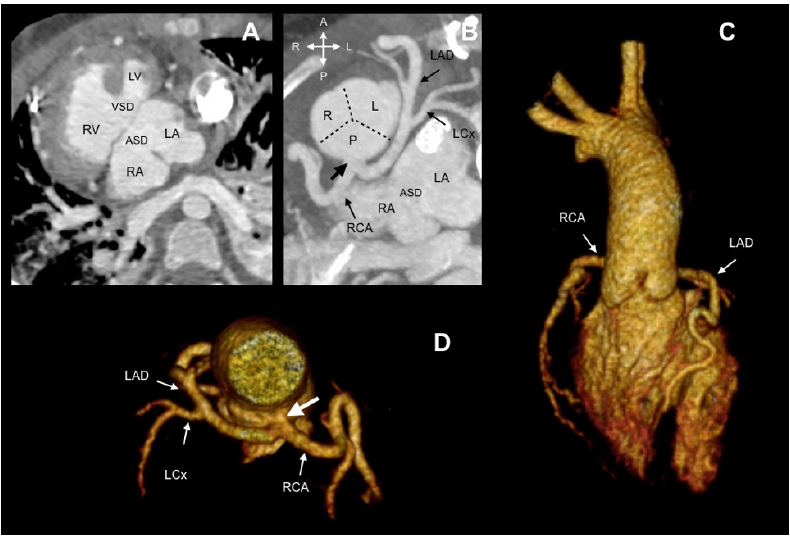
Figure 6. Case 17. A 10-year-old child with pulmonary atresia and common atrioventricular canal type C of Rastelli. ( A ) Oblique axial view showing atrial situs inversus, common atrioventricular connection, atrial and ventricular septal defect. ( B ) The SCA (thick arrow) arises from the posterior sinus, which gives origin to the RCA and left main stem. ( C , D ) A 3D volume-rendered image showing a posterior SCA. Ao: Aorta. ASD: Atrial septal defect. LA: Left atrium. LAD: Left anterior descending coronary artery. LCx. Left circumflex. LV: Left ventricle. NF: Non-facing sinus. RA: Right atrium. RCA: Right coronary artery. RV: Right ventricle. VSD: Ventricular septal